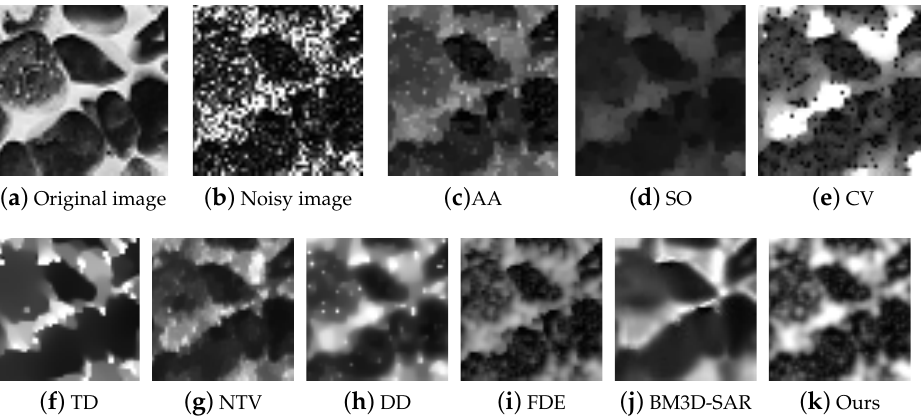
Figure 6. The despeckled results on the satellite2 image: ( a ) Noisy: L = 1. ( b – j ) Despeckled results.